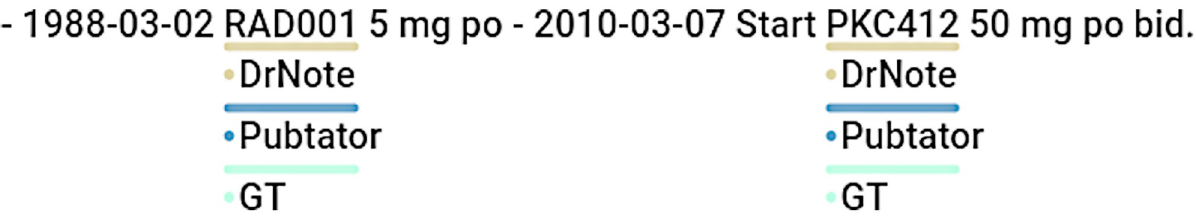
PLOS Digital Health | https://doi.org/10.1371/journal.pdig.0000086 August 15,